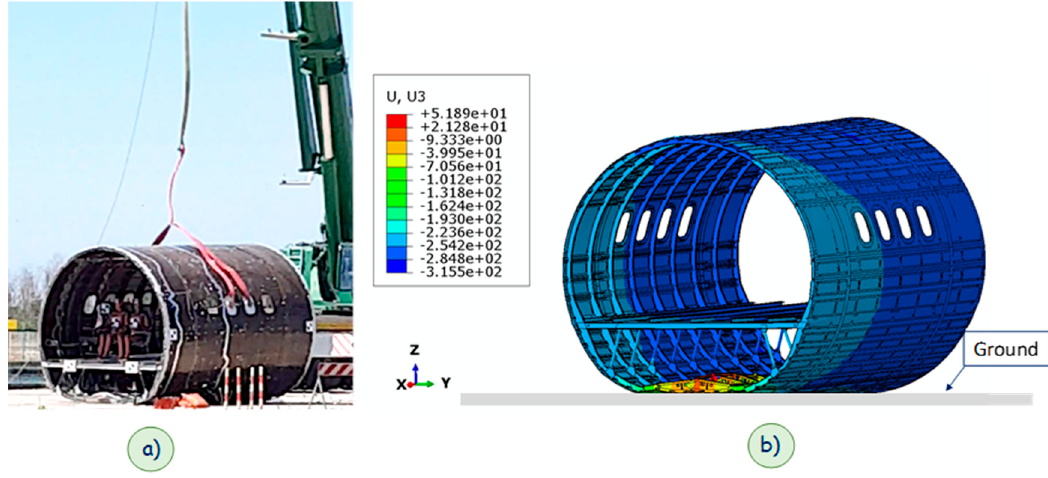
Figure 8. Frame of the fuselage section impact with ground: ( a ) Experimental test; ( b ) numerical simulation (units in mm).